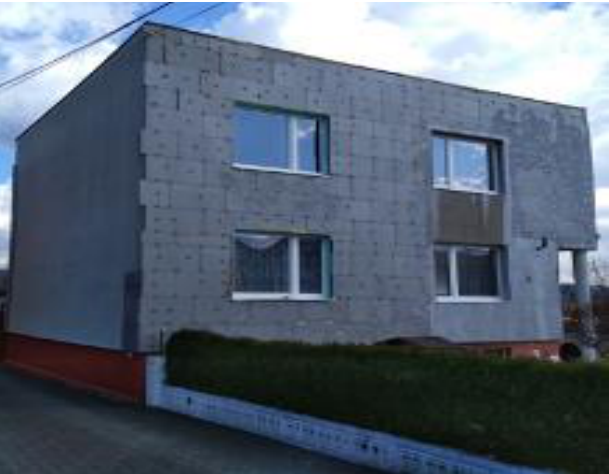
Figure A1. House with ice storage system installation .